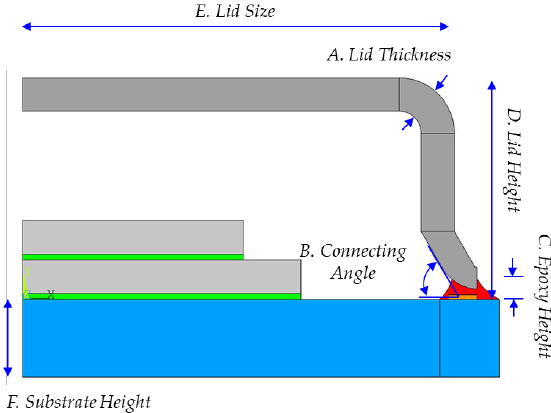
Figure 9. The contact stress (simulation result) and the SEM observation (experimental testing result) of the hermetic MEMS package with a vent hole and without a vent hole.